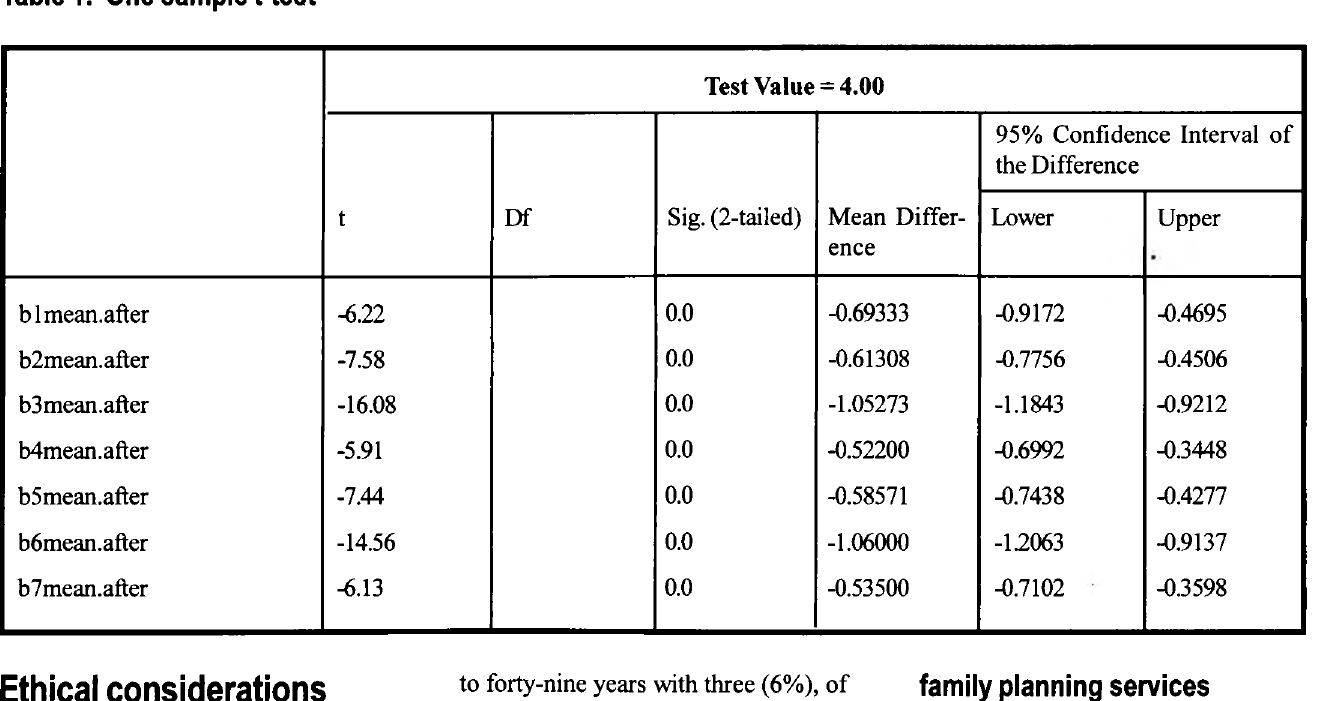
Table 1: One sample t-test